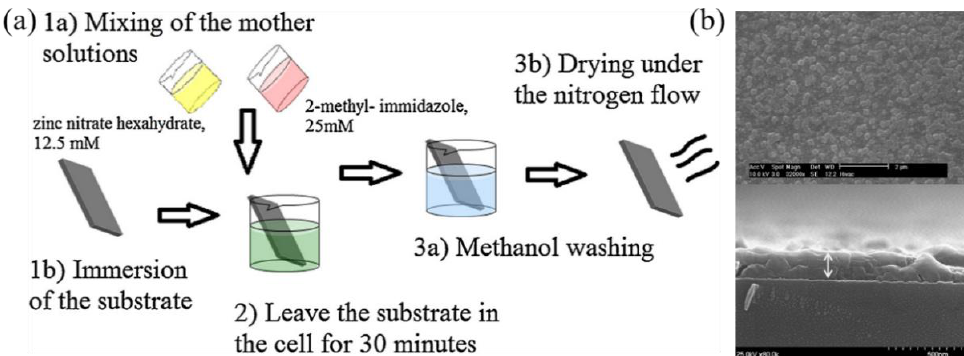
Figure 13. ( a ) ZIF-8 fabrication methodology. ( b ) Top view and cross-sectional SEM images of ZIF- 8 films grown on glass substrates. Adopted from [121]. Under a Creative Commons